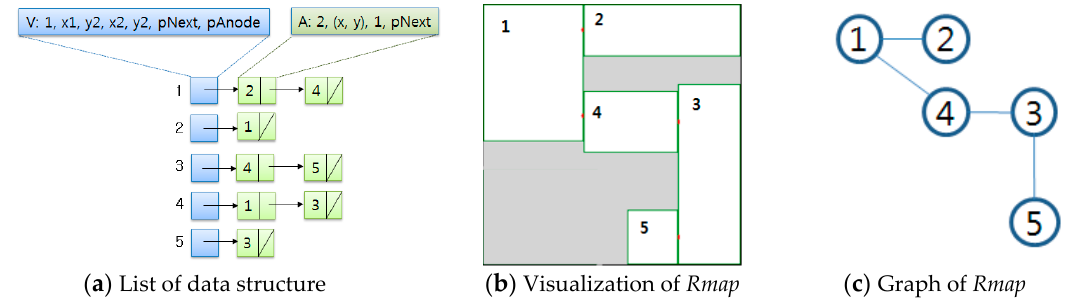
Figure 5. The data structure for the Rmap . ( a ) the data structure composed of the VNode and the ANode , the blue box is the VNode , and the green box is connected ANode ; ( b ) The visualization of the structure; ( c ) The graph representation.